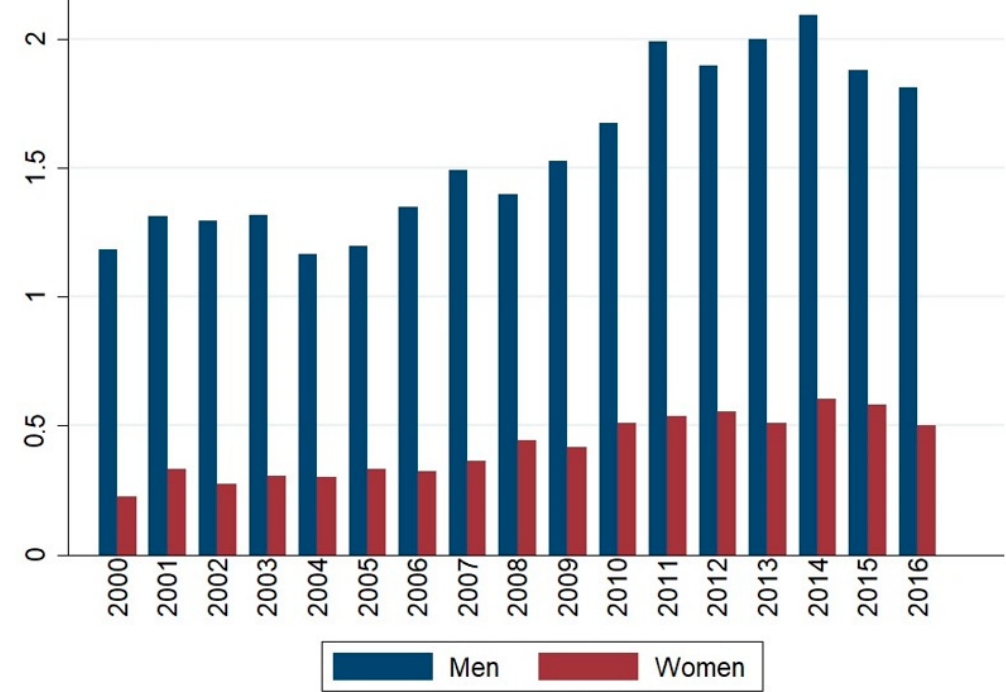
Figure 1. Mean of daily suicides per year in Mexico City 2000–2016. Table 1. Daily Concentrations of Pollutants and Weather Conditions in Mexico City, 2000 to 2016.